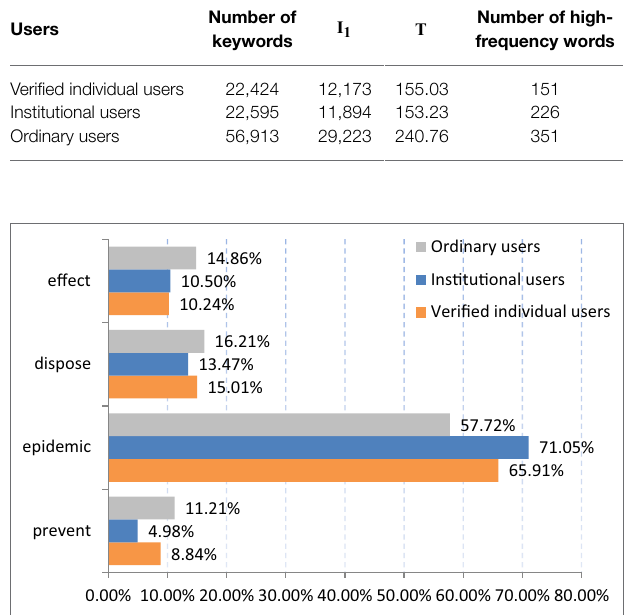
FIGURE 5 | Distribution of the four topics in the three user